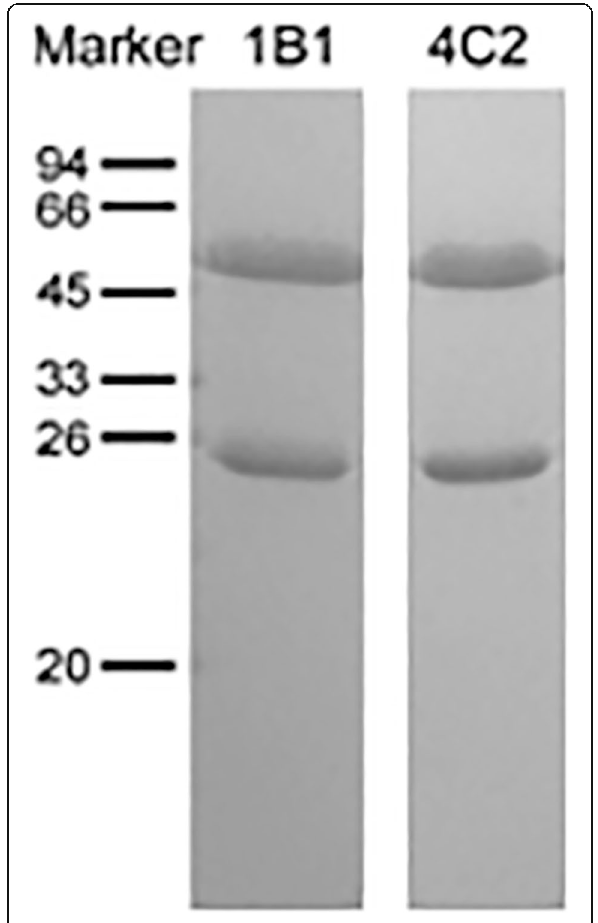
Fig. 1 SDS-PAGE analysis of purified mAbs. The mAbs of 1B1 (lanes 1) and 4C2 (lanes 2) were purified and analyzed as described. The two bands with a molecular weight of 25 K and 50 K respectively in each lane correspond to the light- and heavy-chain of that